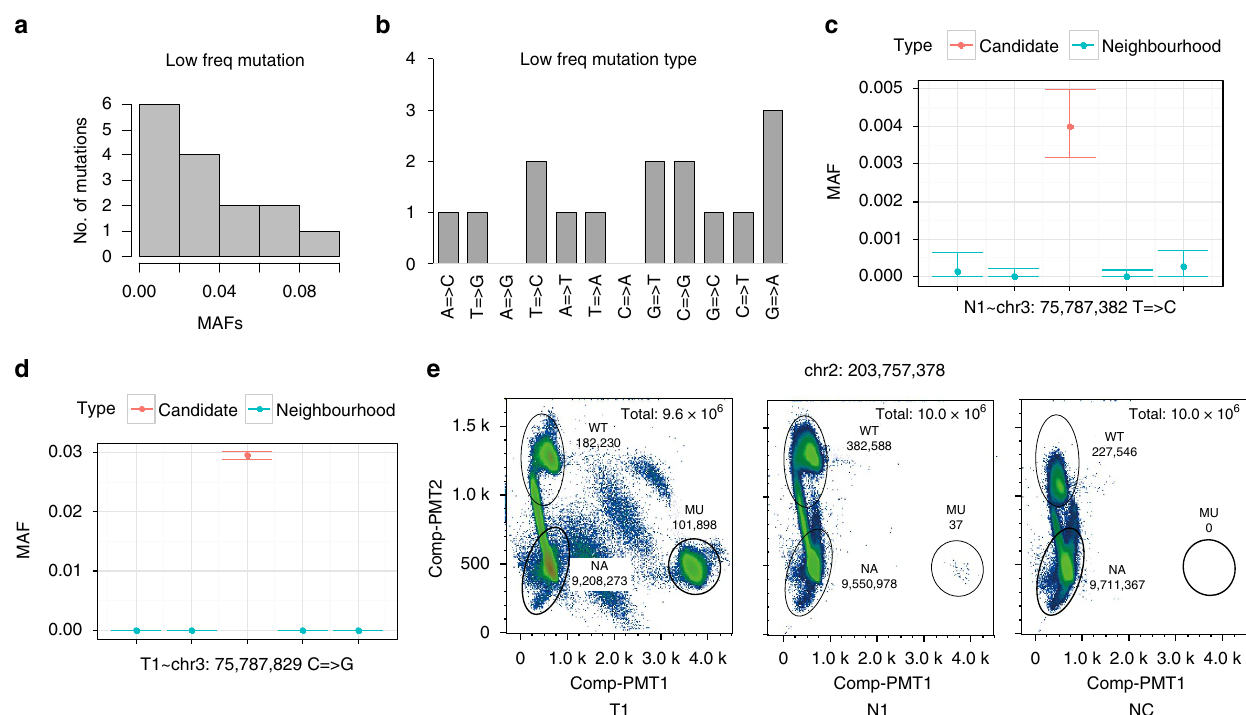
Figure 5 | Mutation frequency and mutation type distribution for low-frequency mutations. ( a ) Mutation frequency of 15 low-frequency mutations detected by o2n-seq. The x axis represents the MAF of these mutations (detected by o2n-sam2sites). ( b ) Distribution of mutations type for the 15 low- frequency mutations. ( c , d ) Validated low-frequency mutations by ultra-deep amplicon sequencing (Methods). The x axis represents the mutation (red) and the sequences ± 2bp from the mutation (blue). The y axis represents the MAF of the mutation. ( e ) Raindrop Digital Droplet PCR was performed to validate ultralow-frequency mutations ( B 0.1%) in the normal sample. T1 is the positive control (high frequency), N1 is the sample and NC is the negative control. Each dot on the graph corresponds to signal from a single droplet. Comp-PTM2 represents the signal for the wild-type (WT) allele, Comp-PTM1 represents the signal for the mutant allele (MU). NA represents droplets that do not contain any probe targets. Colour of the clusters represents the density of dots. Table 3 | Mutations displaying ultralow frequencies in normal sample (N1) but high frequencies in tumour samples (T1 and T2).